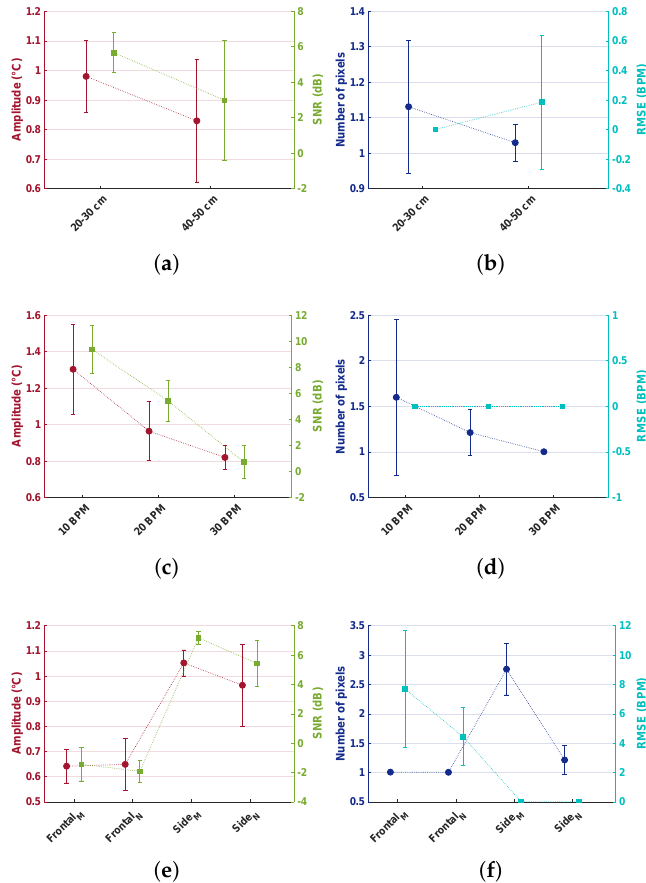
Figure 4. Overview of the differences in amplitude, SNR, number of pixels, and RMSE in Dataset A: ( a , b ) results for signals acquired at different distances; ( c , d ) comparison of different Respiration Rates (RRs); ( e , f ) different orientations and oral and nasal respiration; M and N indicate respectively mouth and nose